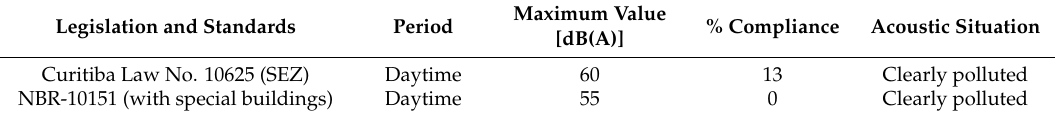
Table 10. Comparison of maximum acceptable values, operationalization phase, daytime.